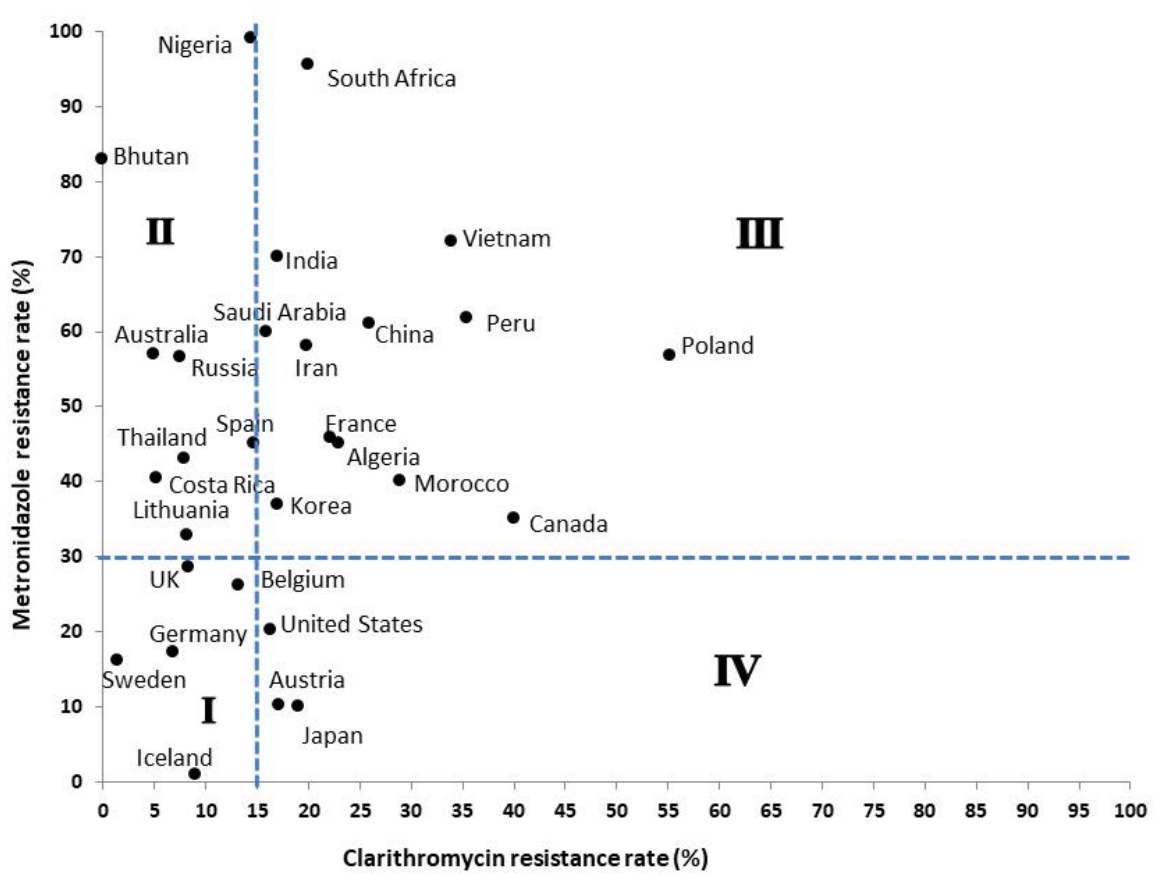
Figure 1. Geographic distribution of clarithromycin and metronidazole resistance. The dotted lines show the threshold levels for clarithromycin and metronidazole resistance rates (15% and 30%, respectively). Both clarithromycin and metronidazole resistance rates are low in countries belonging to area I. Clarithromycin resistance is low but metronidazole resistance is high in countries of area II, whereas in the countries belonging to area III both clarithromycin and metronidazole resistance rates are high. In countries of area IV, the clarithromycin resistance is high but metronidazole resistance is